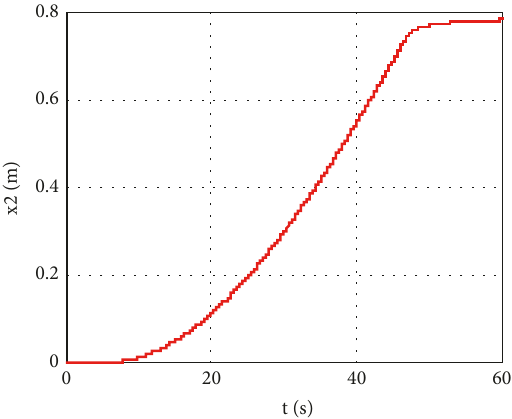
Figure 4: Time dependence of the robot left wheel angular velocity (control action).